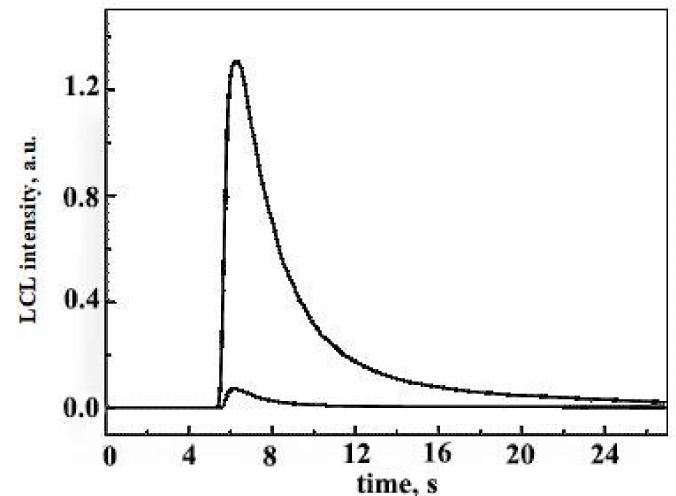
Figure 9. Typical luminol-enhanced chemiluminescence (LCL) signal. The specific experimental conditions were as follows: 100 pM of LOOH, luminol 0.1 mM, 5% methanol, 0.025% TRITON X-100, buffer CAPS 0.1 M, pH 10, final volume of 3 mL. The reaction started with addition of hemin 5 × 10 − 6 M. The lower curve shows emission in the absence of luminal. Adopted with permission from [54]. Copyright 2009,